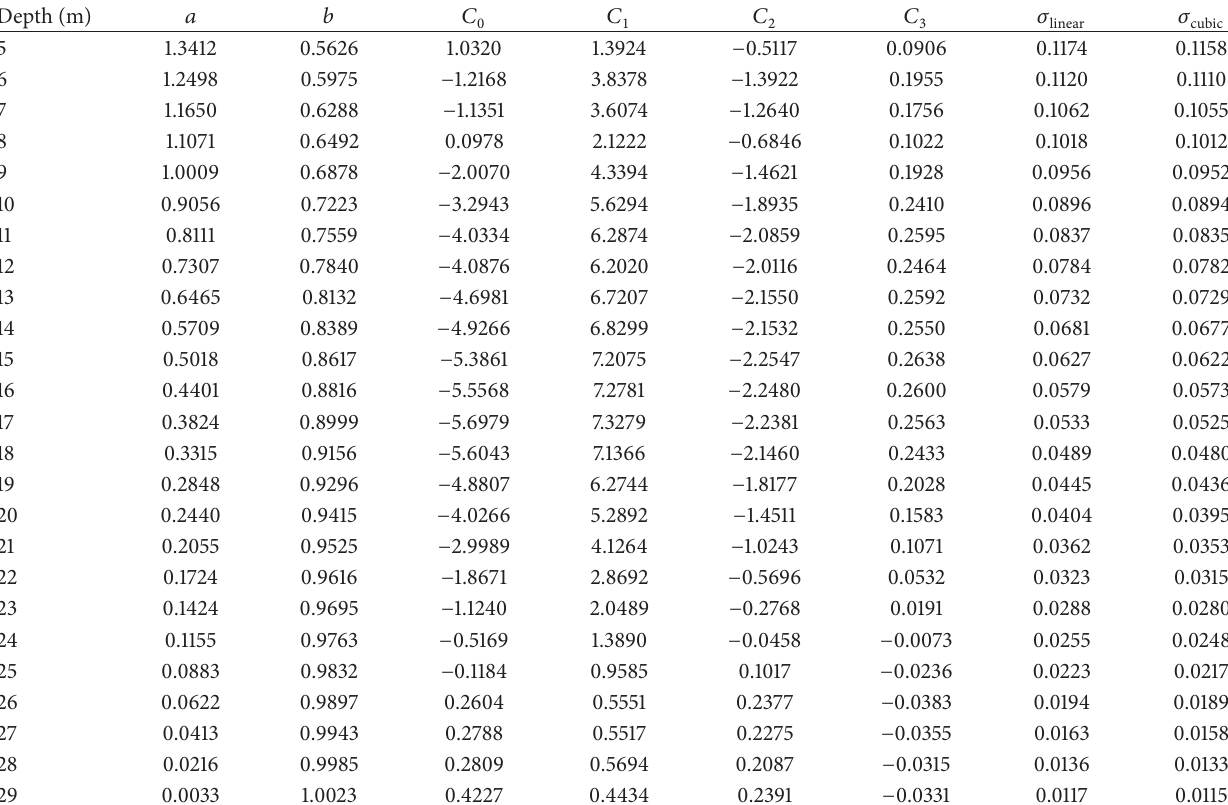
Table 3: Coefficients and natural logarithm of the standard deviation for (4) and (6) from Kiknet profiles.